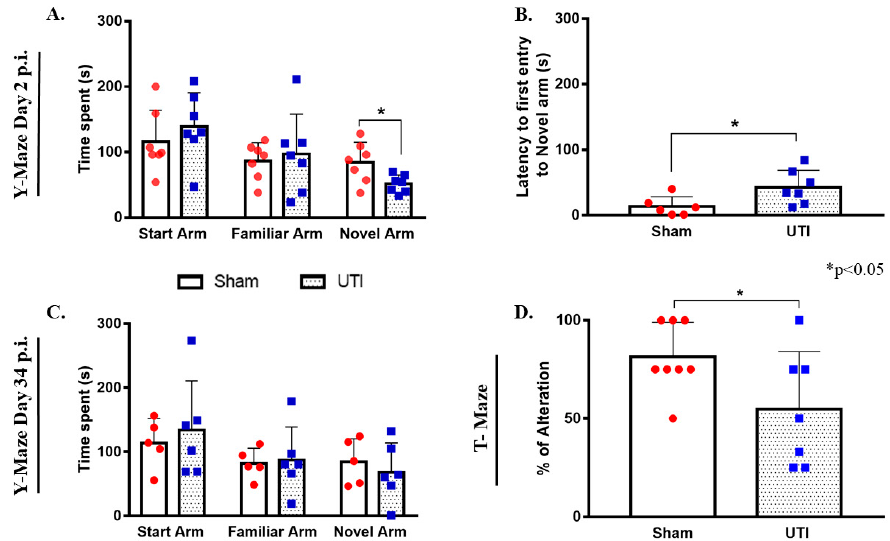
Figure 11. Rats with a UTI spend less time exploring the novel arm in the Y-maze and score lower alternation rates in the T-maze. ( A ) The total time spent in the novel arm by rats with a UTI ( n = 7) is significantly lower than that spent by sham rats ( n = 7) in the Y-maze on day 2 post infection. ( B ) Rats with a UTI ( n = 7) had longer latency to enter the novel arm as compared to the sham group ( n = 6) in the y-maze performed on day 2 post infection. Statistical significance for latency and time spent in the novel arm between the sham group and rats with a UTI was assessed using an unpaired Student’s t -test. ( C ) Rats with a UTI ( n = 6) spent a comparable time in all arms of the Y-maze as compared to the sham group ( n = 5) on day 34 post infection. ( D ) Rats with a UTI ( n = 7) scored a significantly lower percentage of correct alteration in the T-maze test as compared to sham rats ( n = 8), unpaired Student’s t -test.